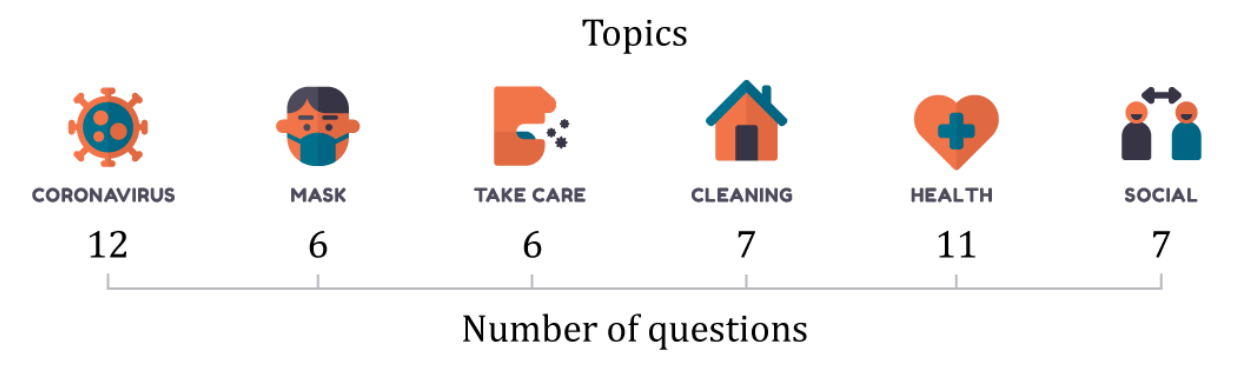
Figure 1. Learning objective topics and number of questions for each topic.